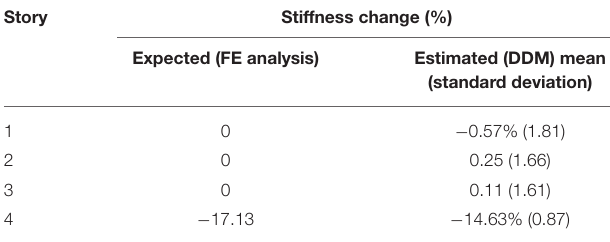
TABLE 4 | Story stiffness change (DC